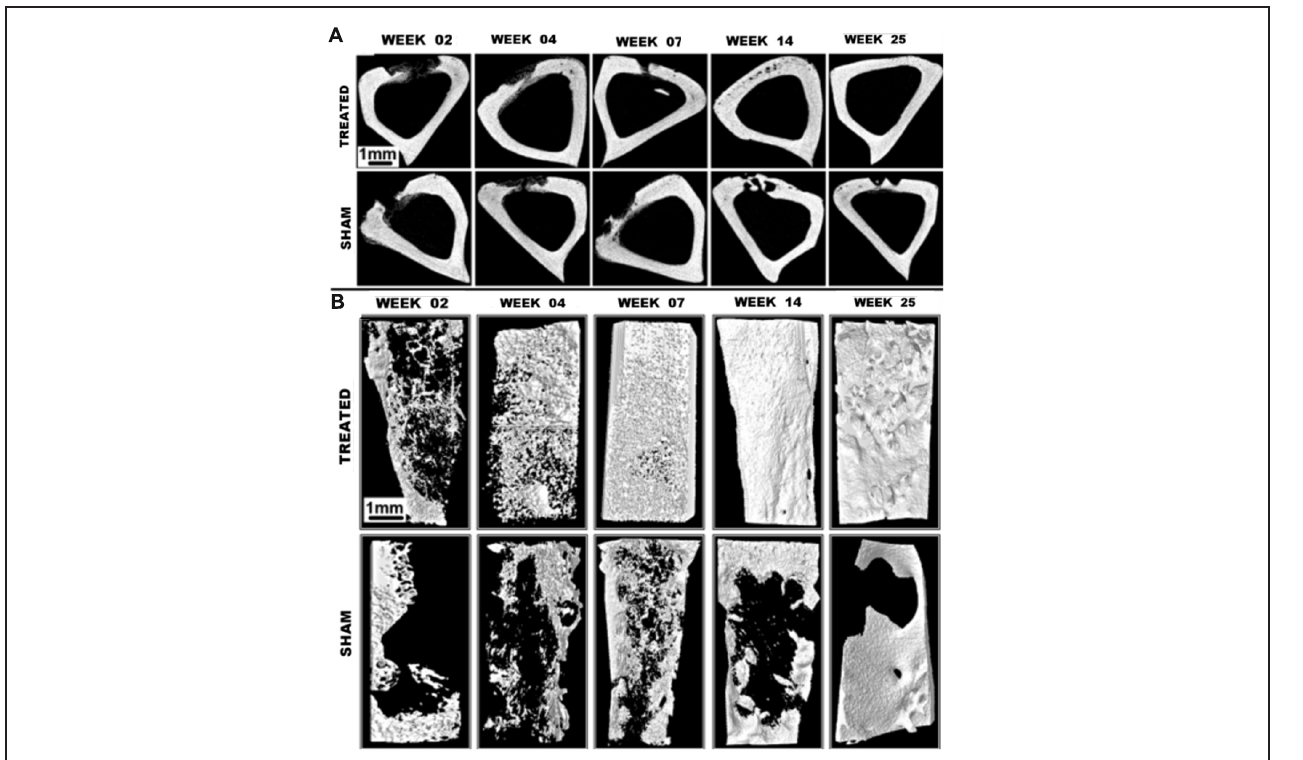
FIGURE 3 | Tibial bone defect micro-CT imaging. (A) Axial micro-CT cross-sections and (B) 3D reconstructions of tibial bone defects after treatment with an osteoinductive gel scaffold. Longitudinal imaging was performed up to 25 weeks. Addition of the treatment gel significantly improves healing of the bone defect. Reprinted from (Sagar et al., 2013) under the Creative Commons Attribution